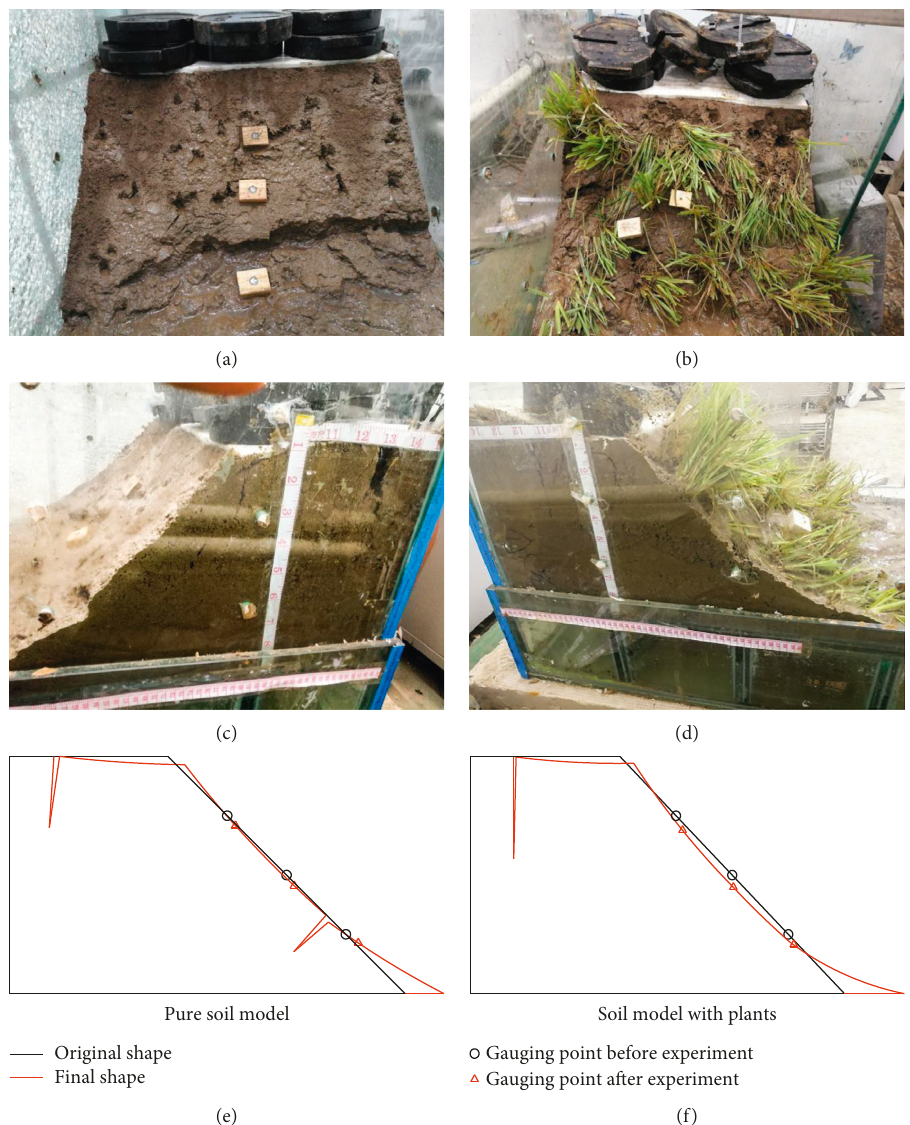
Figure 9: Destruction photos of the model test. (a). Surface destruction of the pure soil slope (b). Surface destruction of the planting slope. (c). Lateral destruction of the pure soil (d). Lateral destruction of the planting soil. (e). Destroyed side profile of the pure soil. (f). Destroyed side profile of the planting